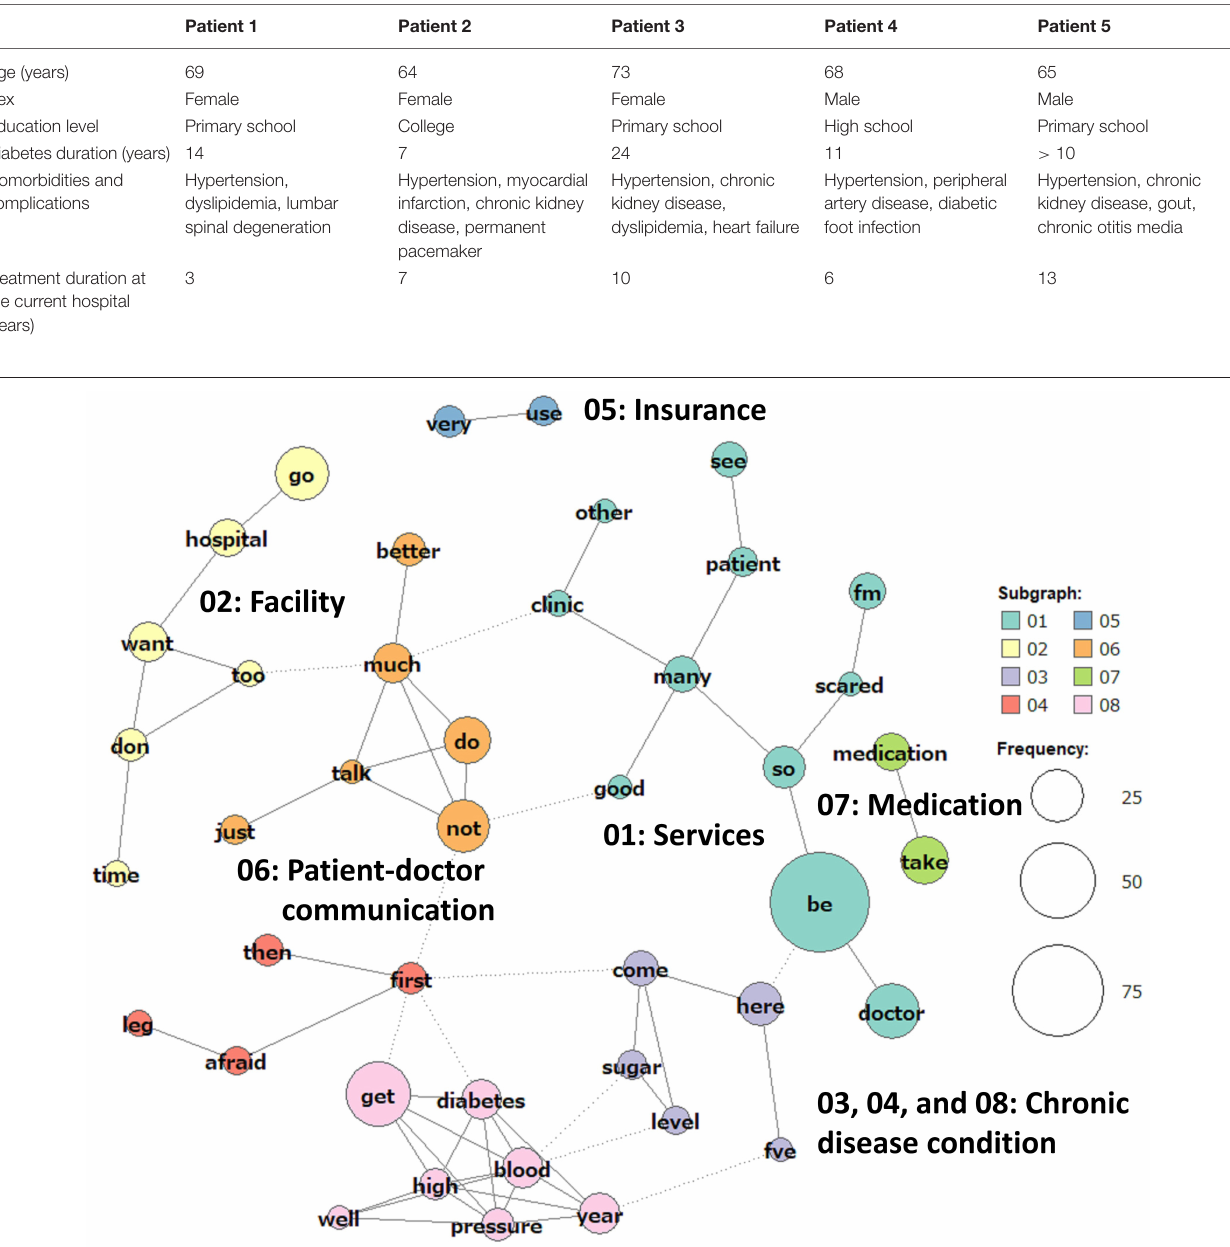
TABLE 1 | Baseline characteristics of the participants.